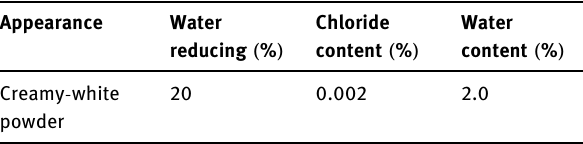
Table 5: Properties of the superplasticizer